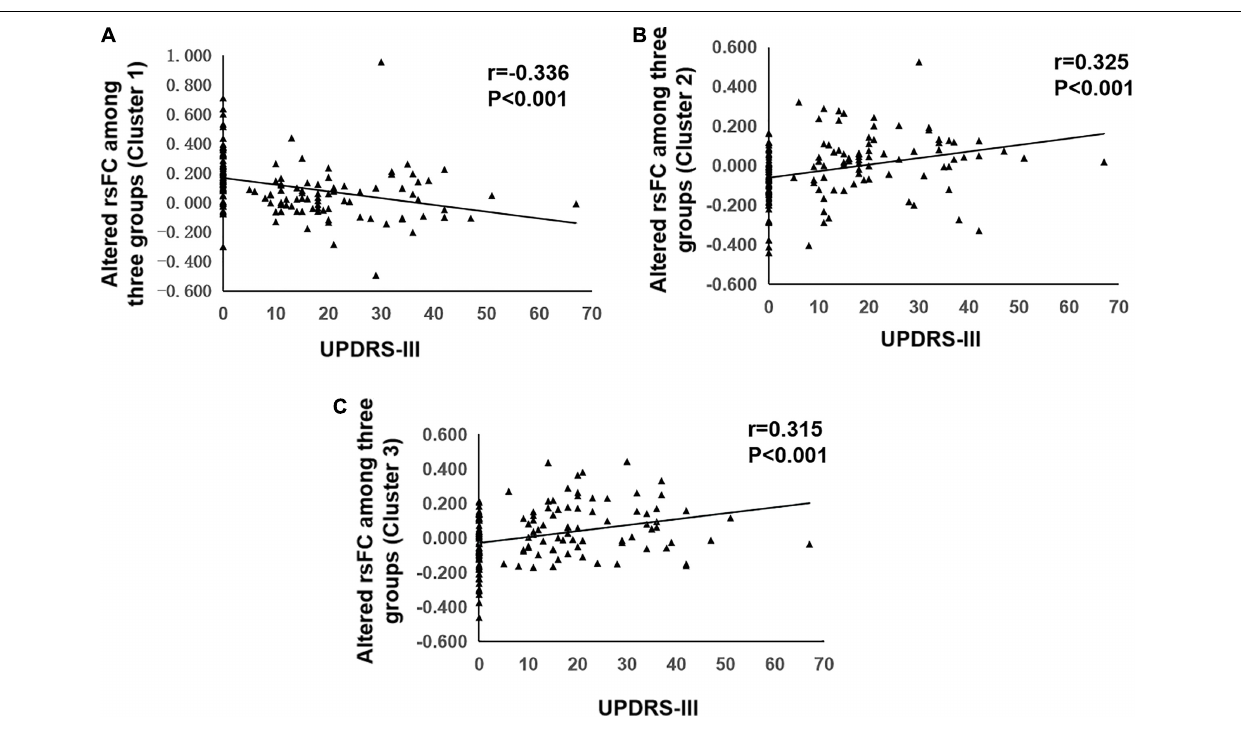
FIGURE 3 | Correlation analysis of UPDRS-III and resting state functional connectivity. (A) Correlation analysis of UPDRS-III and altered rsFC of Cluster 1. (B) Correlation analysis of UPDRS-III and altered rsFC of Cluster 2. (C) Correlation analysis of UPDRS-III and altered rsFC of Cluster 3. rsFC, resting-state functional connectivity; UPDRS-III, part III of the Unified Parkinson’s Disease Rating Scale.